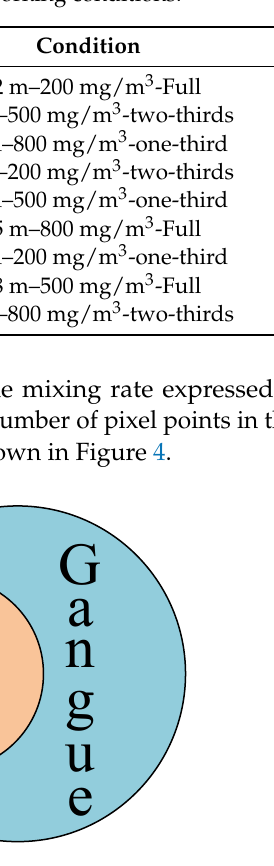
Figure 4. The Schematic diagram of Coal Content. Table 3. Nine working conditions.